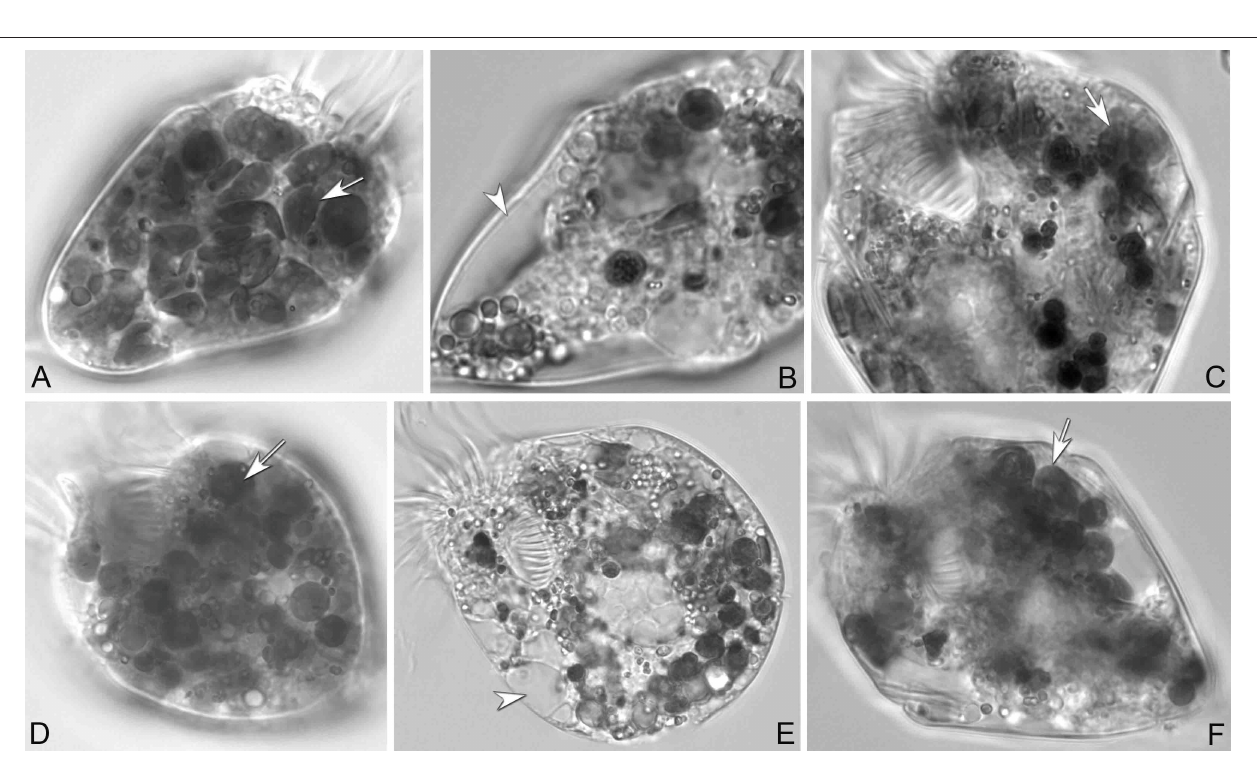
FIGURE 7 | S. rassoulzadegani from cultures grown on T. chui PLY429 at 12:12 L:D (A–C) or 24 D (D–F) . (A,D) Cells with adequate algae food (arrows). (B,E) Cells starved for 72h; arrowheads mark empty vacuoles. (C,F) Algae were taken up again (arrows) after new algal food was added. Even in complete darkness (F) , fed cells retain some